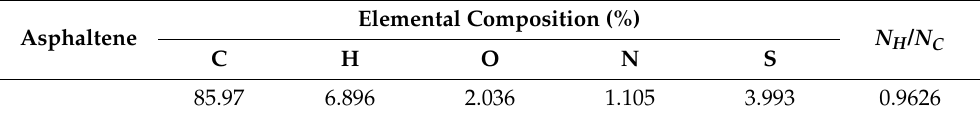
Table 4. Elemental content of asphaltene revealed by elemental analysis.